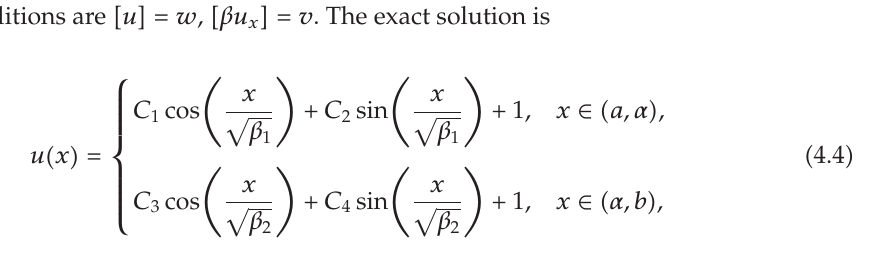
Table 3: Convergence analysis of Example 4.1 by Lagrange collocation method (cid:5) β